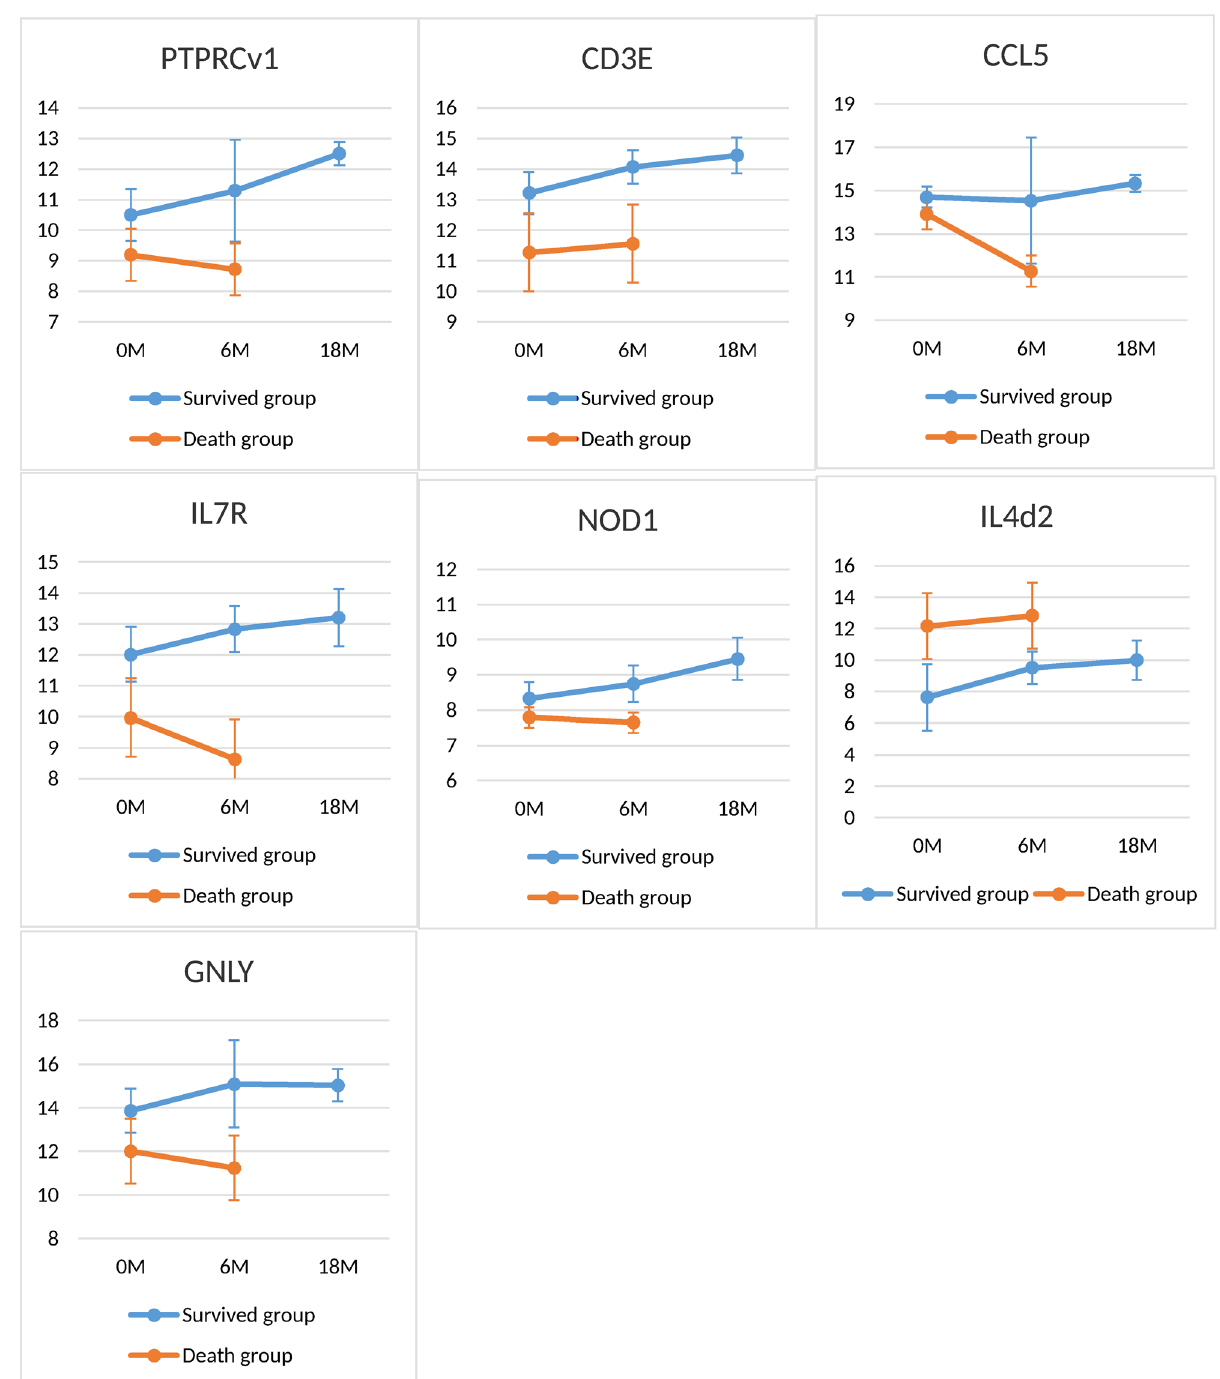
Figure 5. Anti-TB treatment response transcriptomic profiles. Median gene expression levels (peak areas normalized to GAPDH and log2-transformed) and standard deviation are shown of the indicated genes at baseline (0 M) and 6 months after treatment initiation (6 M) and (18 M) of study